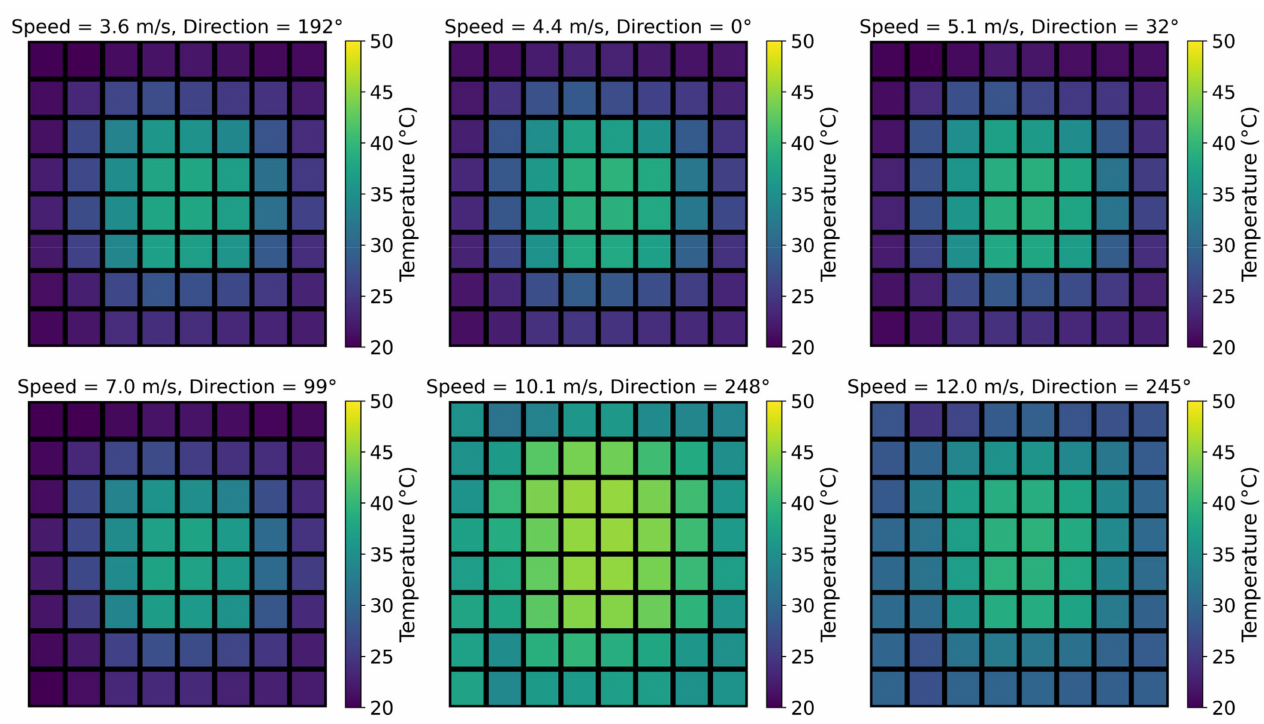
Figure 2. Temperature distribution measurements of the heat sink at different wind speeds and